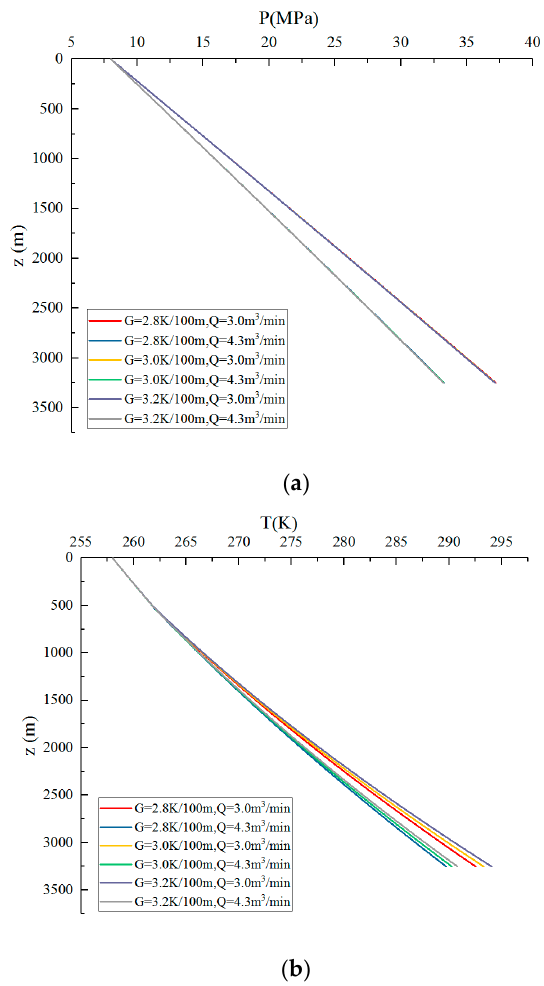
Figure 13. Effect of geothermal gradient: ( a ) CO 2 pressure profile; ( b ) CO 2 temperature profile.